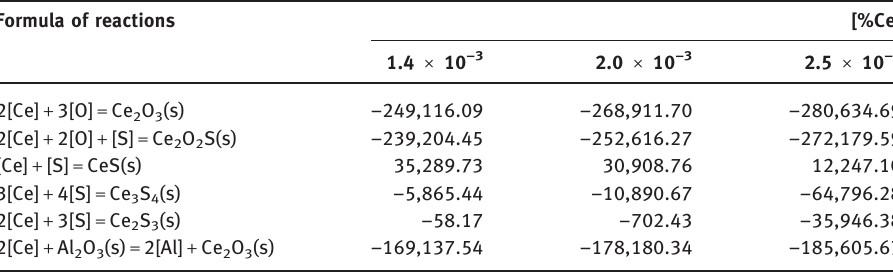
Table 7: Calculated values of Δ G for experimental steels with different Ce contents at 1,873K. Formula of reactions [%Ce]  .  ×  –   .  ×  –   .  ×  – 